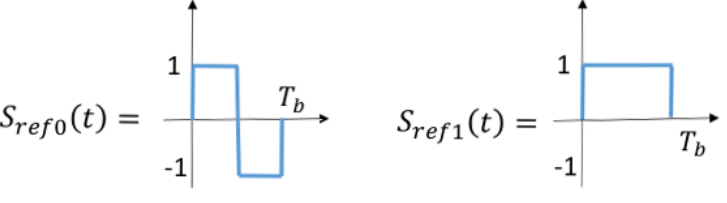
Figure 2. Reference waveforms signals S ref 0 ( t ) and S ref 1 ( t )